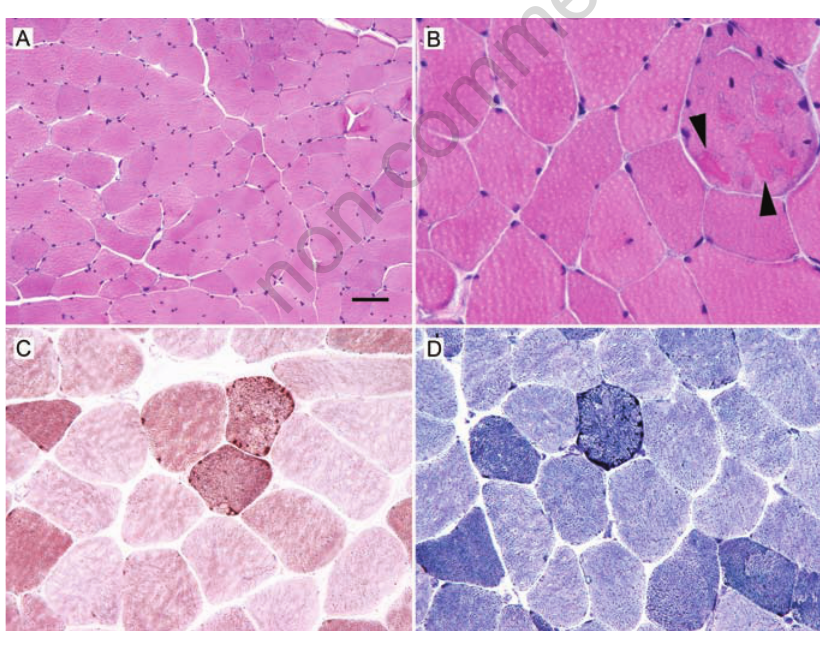
Figure 1. Light microscopy of the sternocleidomastoid muscle showing mild to moderate variation in fiber size (A: Haematoxylin & Eosin staining), a fiber with eosinophilic cyto- plasmic bodies (B: arr owheads; Haematoxylin & Eosin staining), moderate subsarcolem- mal accentuation of SDH activity C, combined COX/SDH histochemistry), and moder- ate subsarcolemmal accentuation of NADH activity (D: NADH histochemistry). Bars indicate 50 µm in A, 20 µm in B, and 25 µm in C and